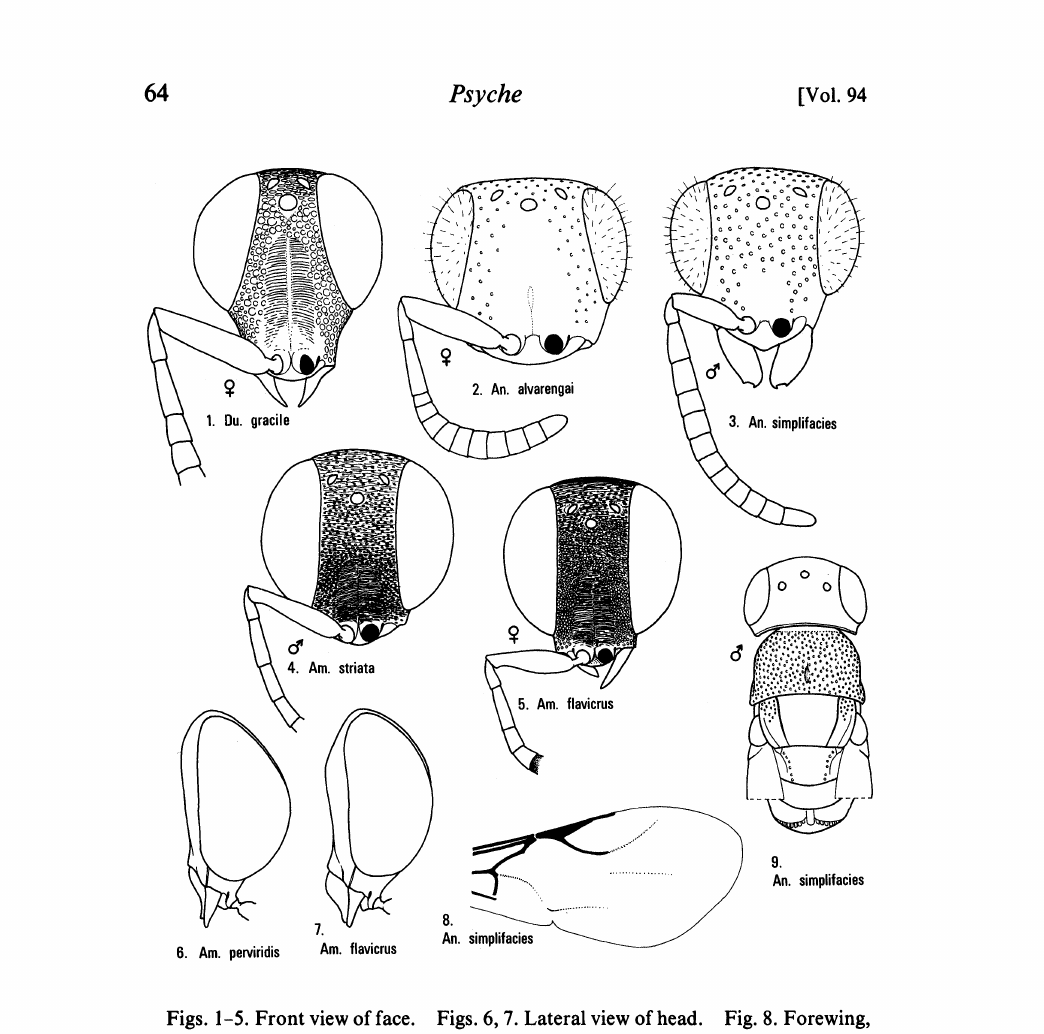
Figs. 1-5. Front view offace. Figs. 6, 7. Lateral view of head. Fig. 8. Forewing, apical two-thirds. Fig. 9. Dorsal view of head and thorax, with wings removed. Am Amisega, An Anadelphe, Du Duckeia. brassy green; rest of thorax greener; pedicel and flagellum